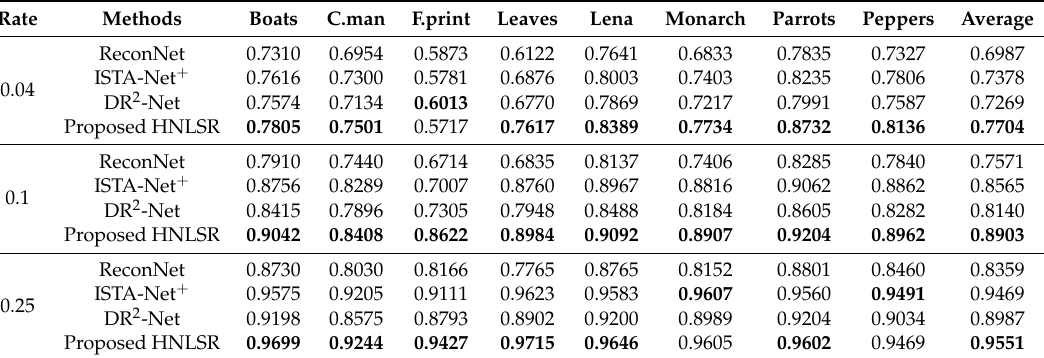
Table 4. FSIM comparison of deep learning methods and the proposed method.